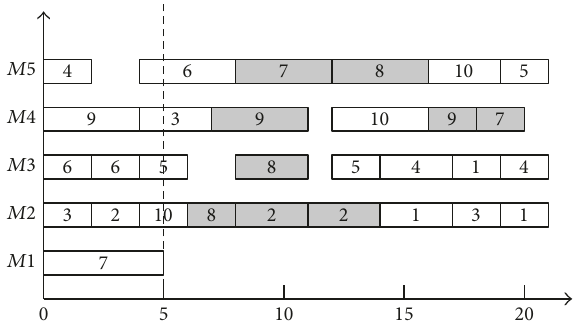
Figure 3: Dynamic rescheduling Gantt chart.